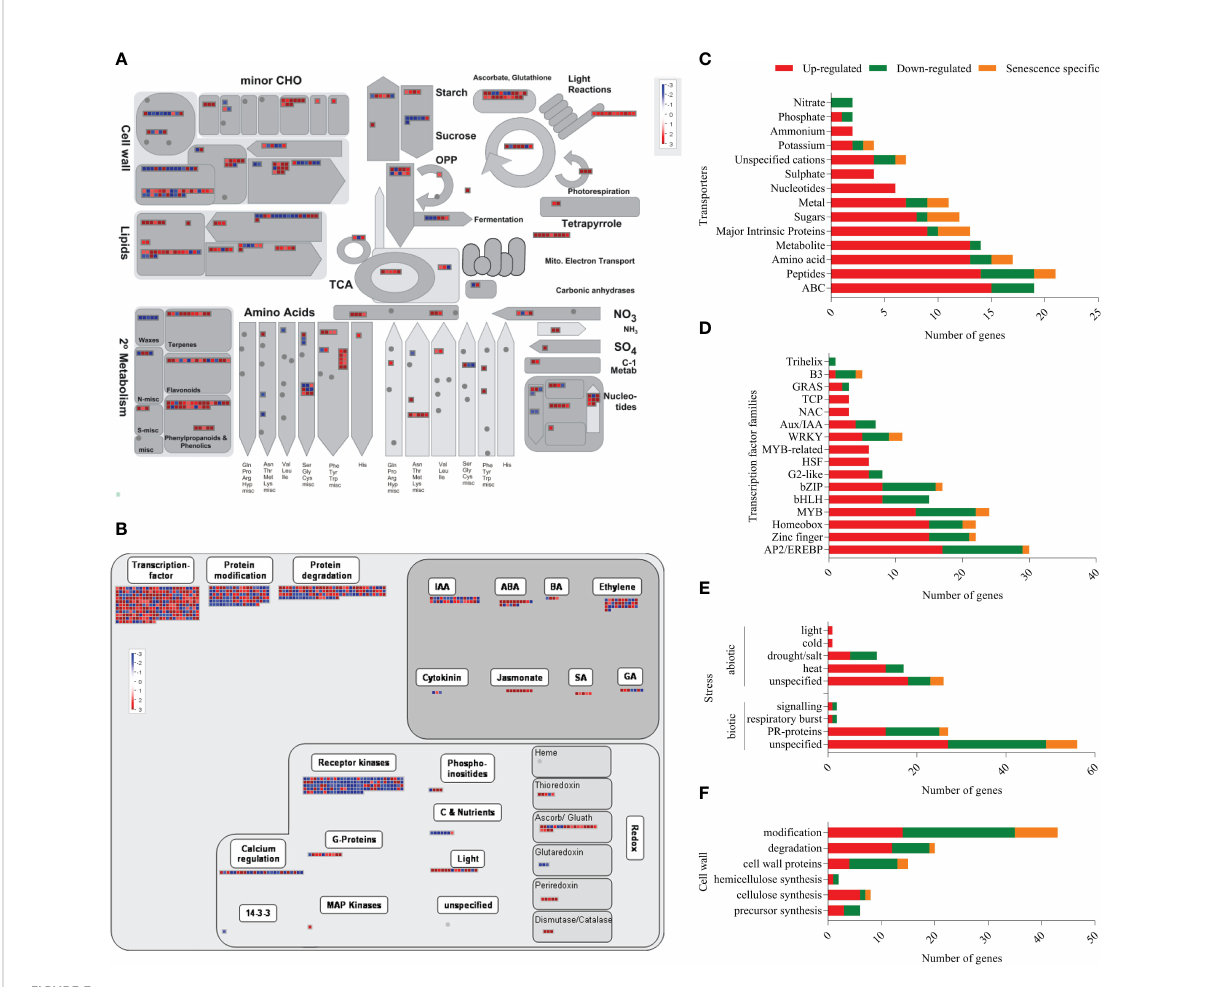
FIGURE 3 Functional annotation of DEGs using MapMan tool. The functional annotation of DEGs were analysed using MapMan tool and overviews of metabolism (A) and regulation (B) are depicted. In the overviews, red boxes represent up-regulated/senescence speci fi c transcripts and the blue boxes represent down-regulated transcripts. The major functional categories of genes: Transporters (C) , Transcription factors (D) , Stress (E) and Cell wall-related (F) are represented as stacked bar graphs. In the stacked bar graphs red bar indicates upregulated genes, green bar shows down regulated genes and orange bar represents senescence-speci fi c genes (day 2-speci fi